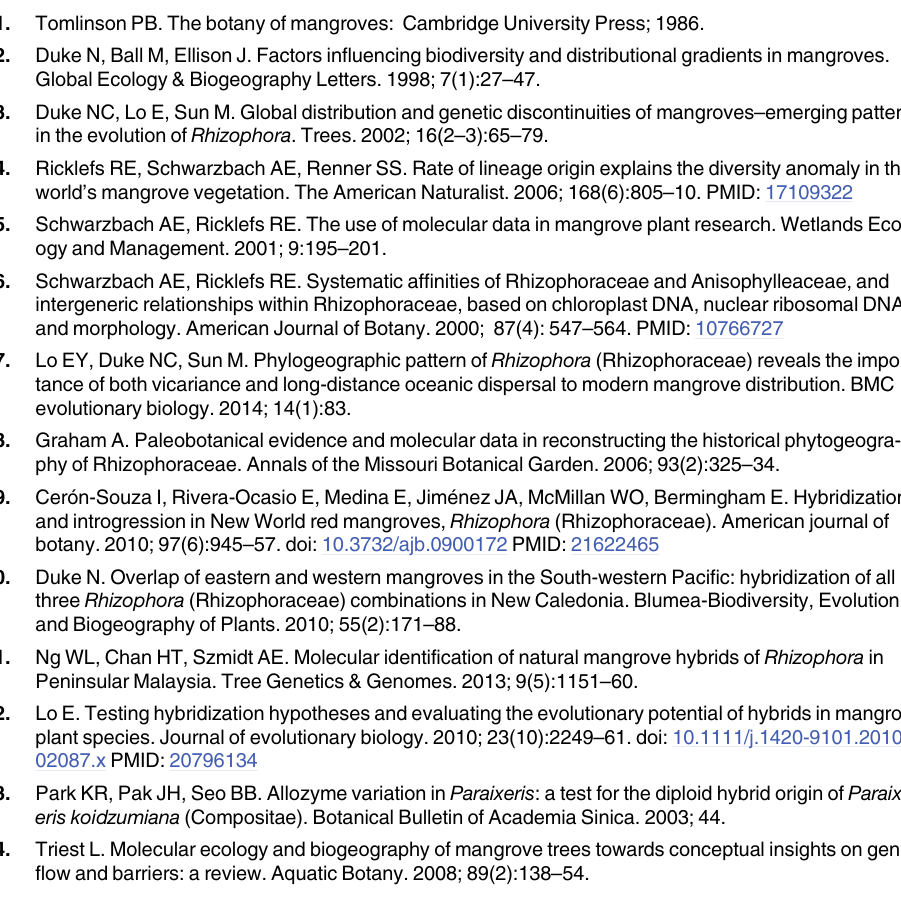
S7 Table. The variable sites at the chloroplast gene trn S- trn G in three taxa of Rhizophora in